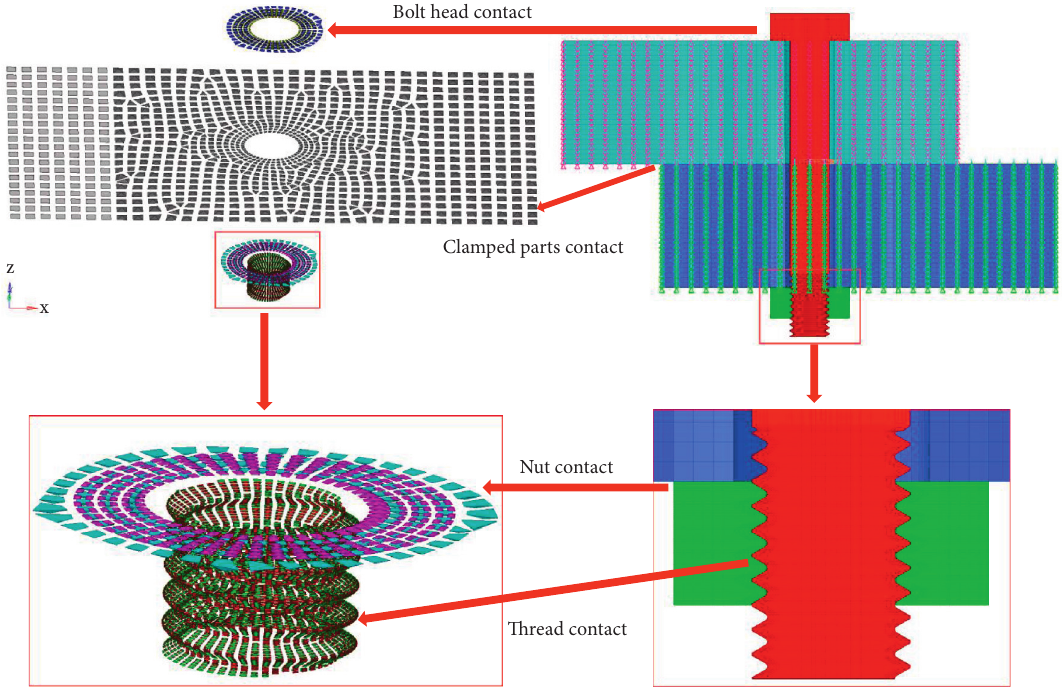
Figure 3: Finite element model of bolt Table 2: Material parameters.